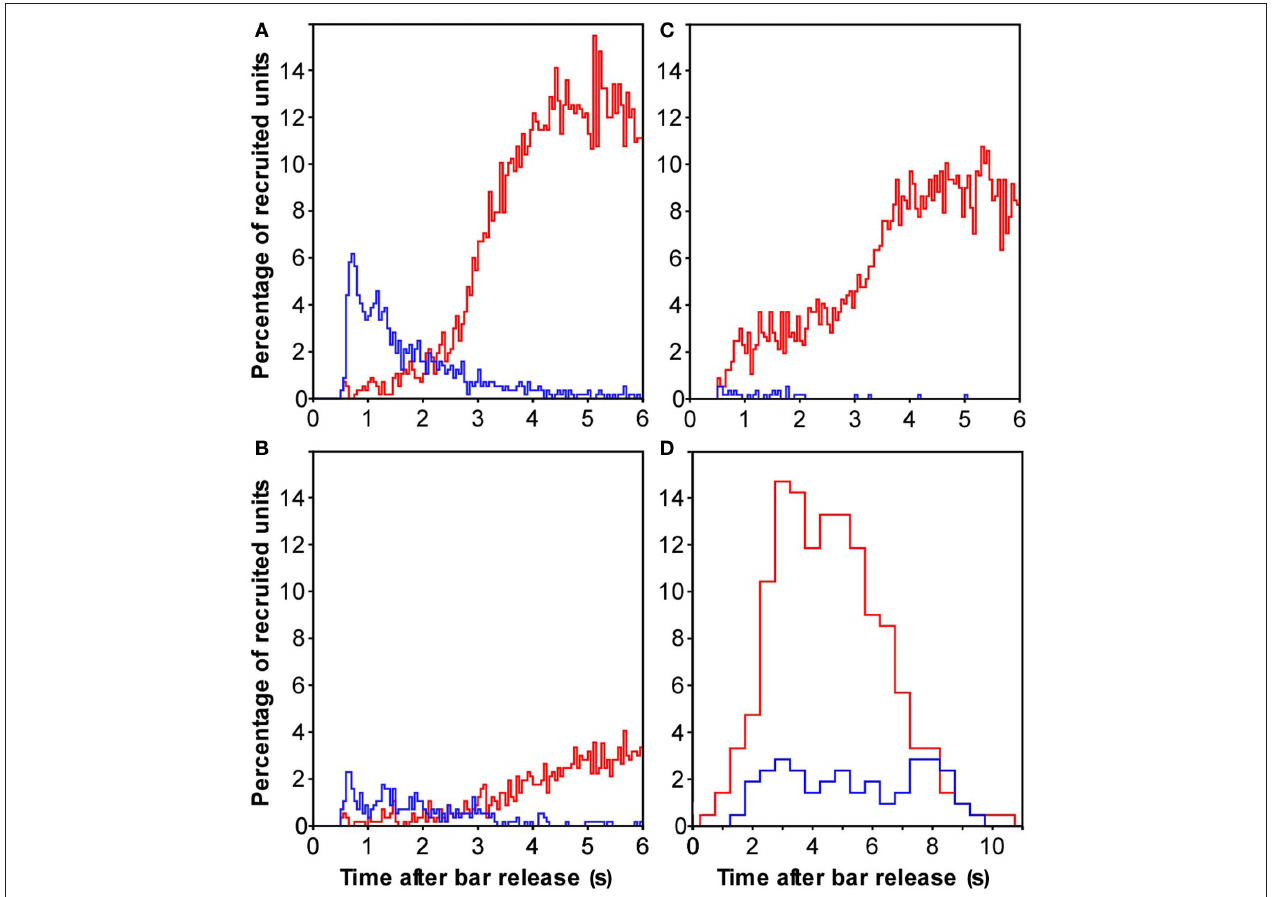
reward mismatch. (C) Reward mismatch coding, as shown in Figure 4B , except that error trials with misses instead of false alarms were used. (D) Recruitment of multiunits whose firing differed between reward conditions with a large and a small reward mismatch. These data were analyzed with the larger bin-size of 500 ms to account for the small number of the two types of error trials.